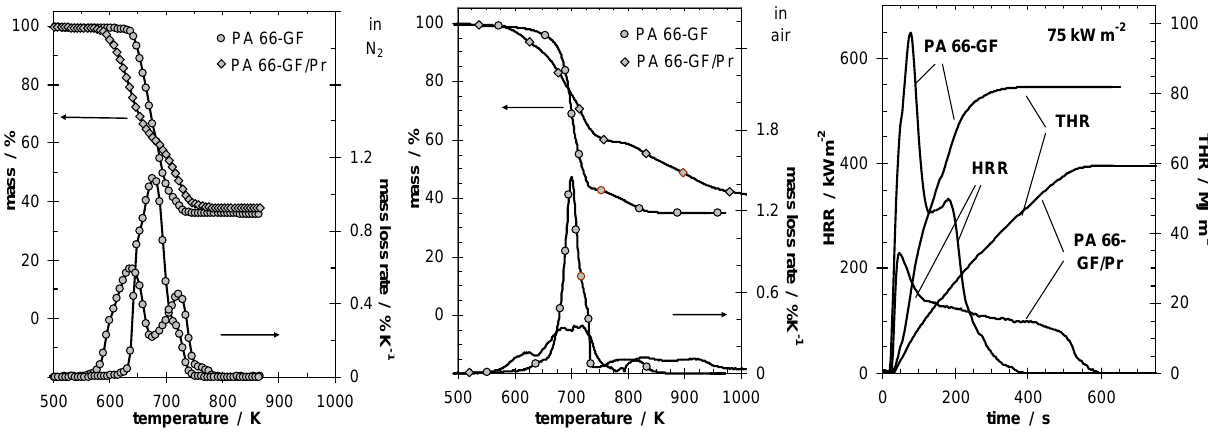
Figure 1. Thermal (left) and thermo-oxidative (middle) decomposition of PA 66-GF and PA 66-GF/Pr (thermogravimetry); cone calorimeter results for HRR and total heat release (THR) (right). PA